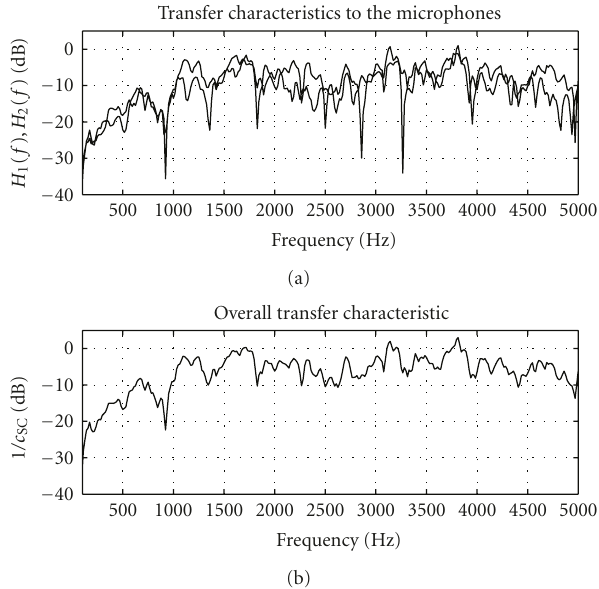
Figure 3: Transfer characteristics to the microphones and of the combined